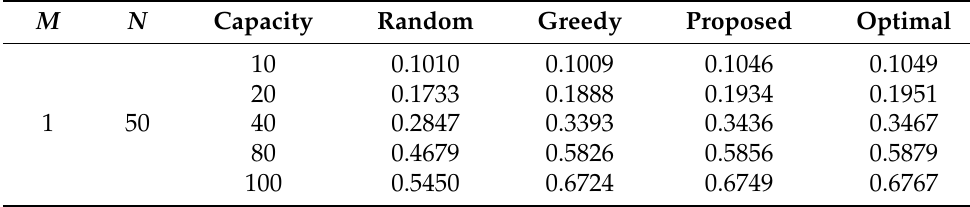
Table 3. Profit ratio of selected items for QI